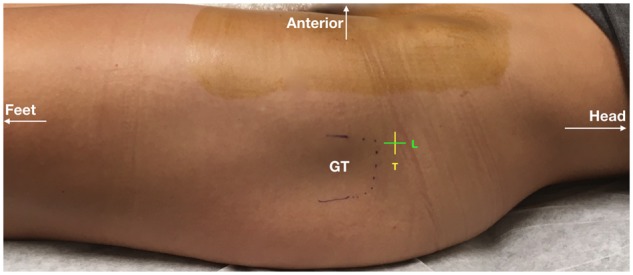
Clinical photograph demonstrating anterolateral portal location on the left thigh and patient orientation preoperatively. In this study, all left hips received a transverse portal and all right hips received a longitudinal portal. L, longitudinal portal; T, transverse portal.